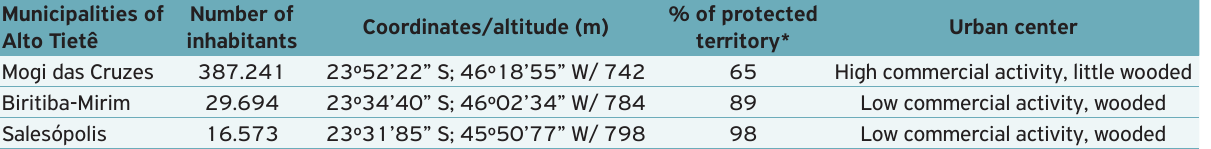
Low commercial activity, wooded